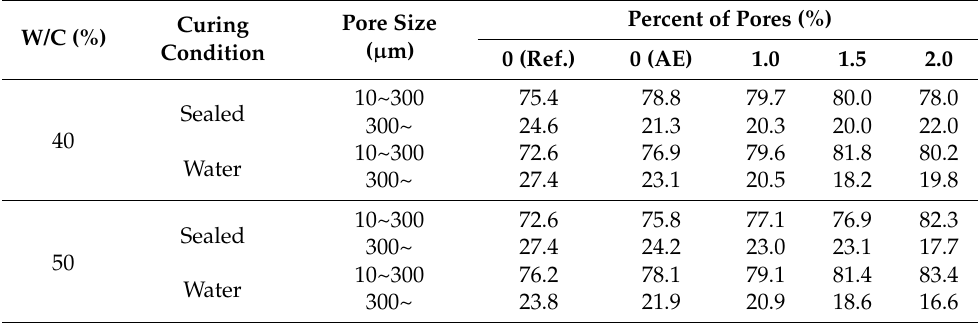
Table 7. Pore distribution according to pore size (300 µ